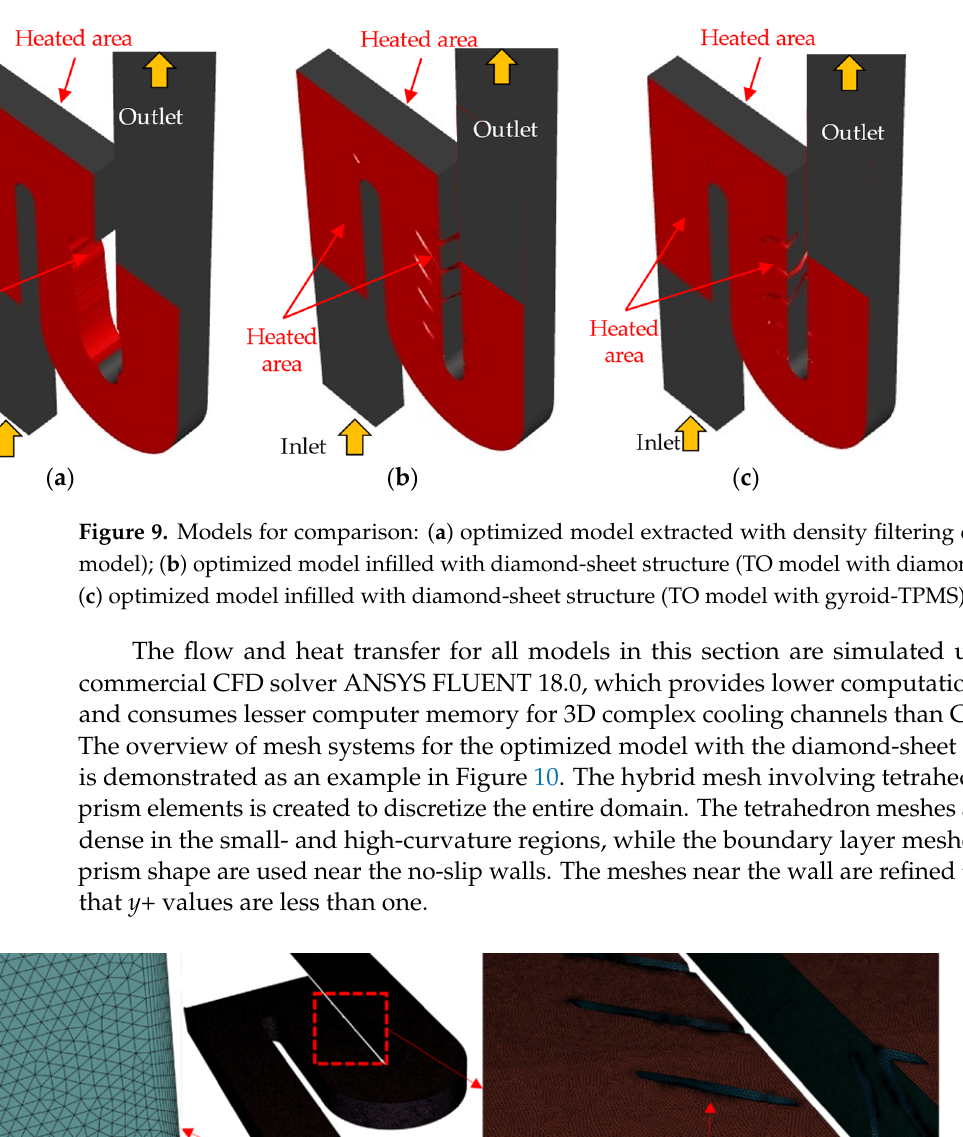
( b ) Figure 8. ( a ) 3D optimal solution including intermediate results; ( b ) topology optimization model infilled with lattice structures. 4.2. 3D Model Comparisons In this section, the optimized model extracted with a density filtering of 0.5 (TO model) is also included to compare with the baseline channel. All models and the bound ‐ ary conditions are shown in Figure 9. These models are applicable at the Reynolds number